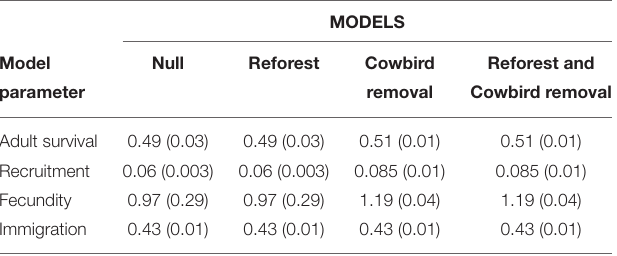
TABLE 2 | Parameter estimate means (SD) used in four metapopulation model scenarios for wood thrushes breeding in small urban forest fragments in and near Newark, Delaware,